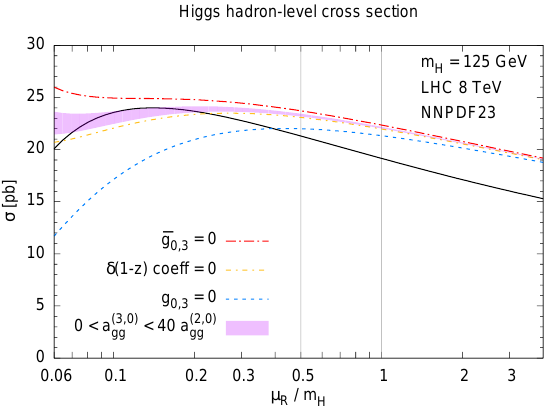
√ s = 8 TeV, using di ff erent guesses s